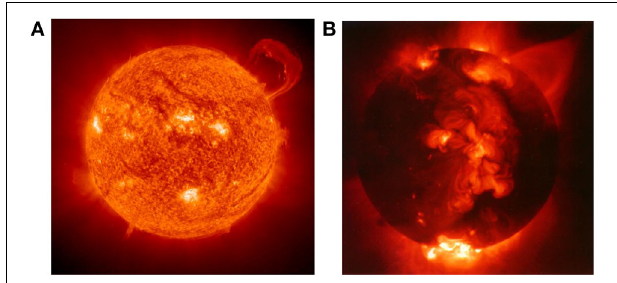
FIGURE 1 | Hannes Olof Gösta Alfvén: 30 May 1908–2 April 1995. Photo credit: Mark Zimmermann, http://zhurnaly . com/HannesAlfven.